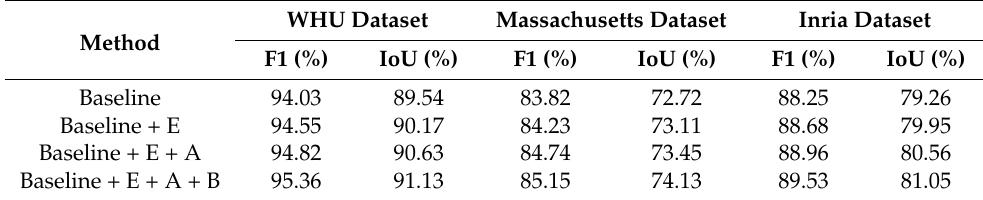
Figure 13. Edge feature visualization of example images of the three datasets. Table 8. Quantitative comparison of the four ablation studies.